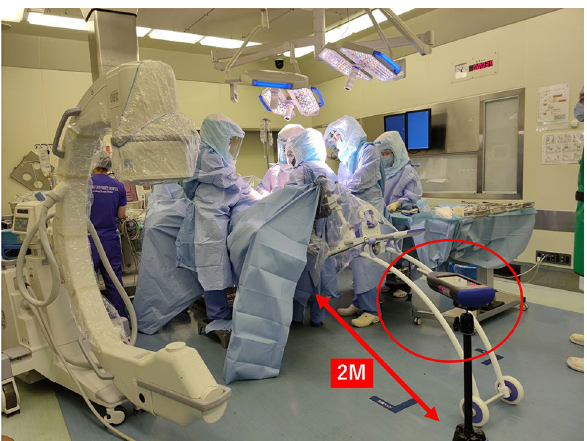
Figure 1. A highly sensitive sound level meter (LA-7500; Onosokki, Kanagawa, Japan) was used to record the hammering sound of stem insertion. In all cases, the sound level meter was set on a tripod mount at 1 meter high and 2 meters away from the surgical table in the same operation